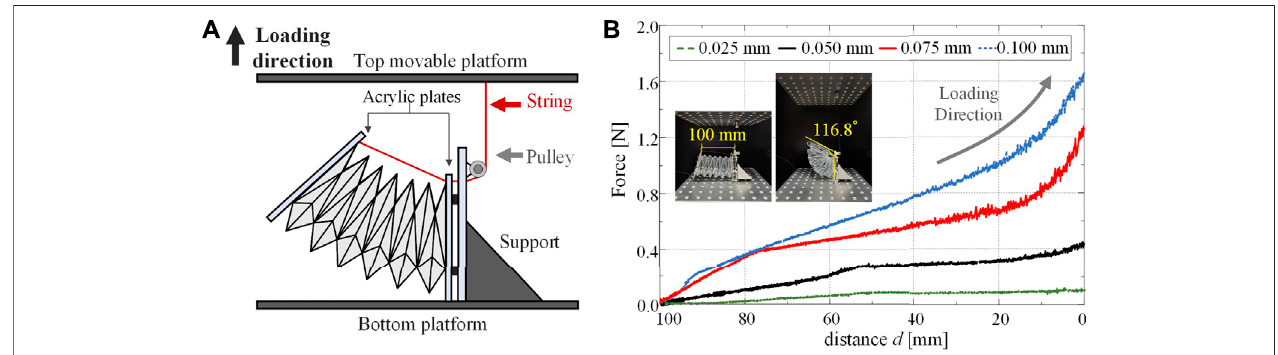
FIGURE 8 | Experiments on the mechanical properties of a six-layer Yoshimura-ori structure prototype for bending deformation. (A) Schematic illustration of the setup for the equivalent bending test. (B) The obtained force-displacement curves for the four prototypes with different fi lm thicknesses. Insets show the initial and fi nal con fi gurations of the prototype (i.e., d (cid:1) 100mm and d (cid:1)